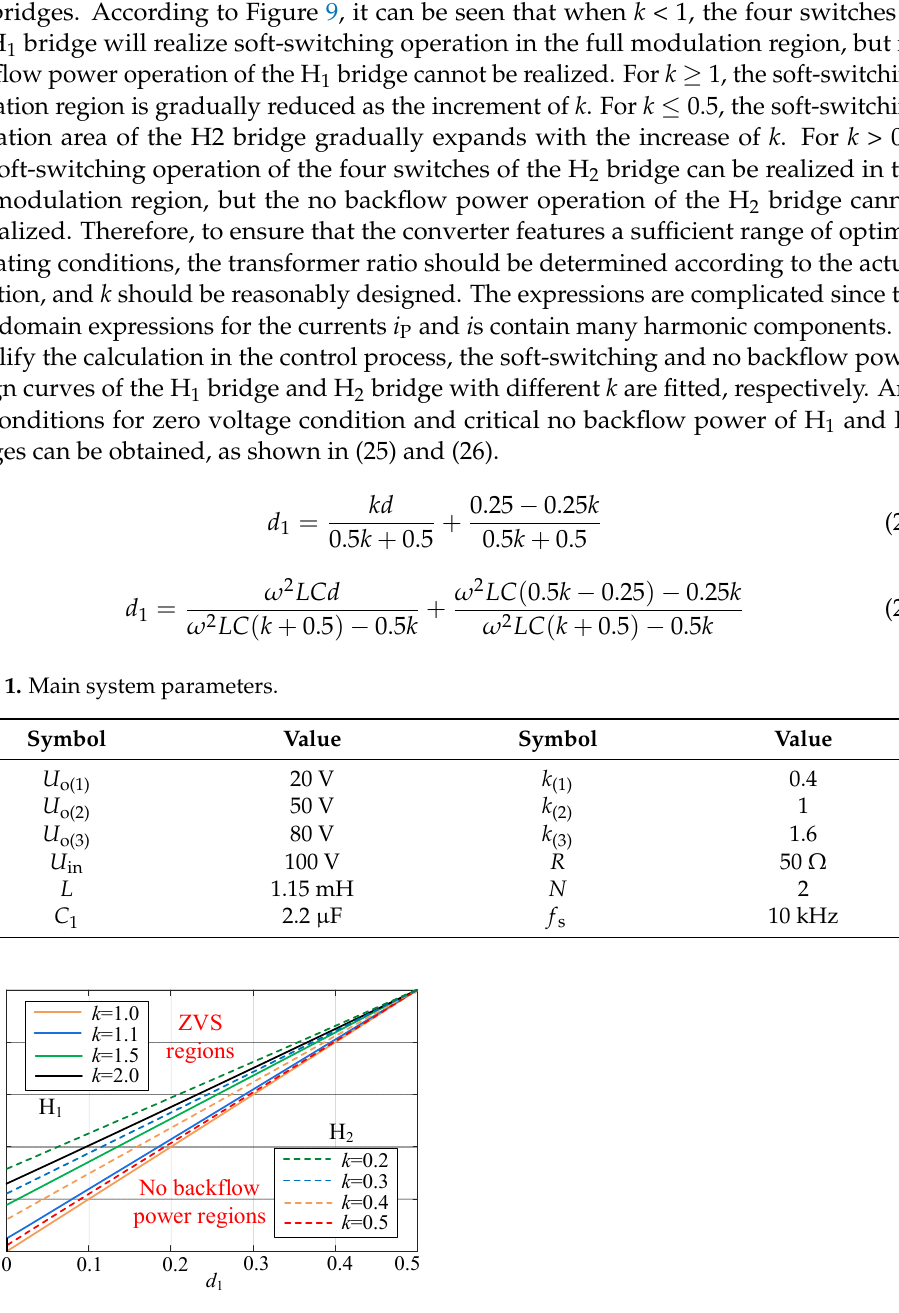
Figure 9. Design curves of no backflow power and soft ‐ switching with DPS modulation.